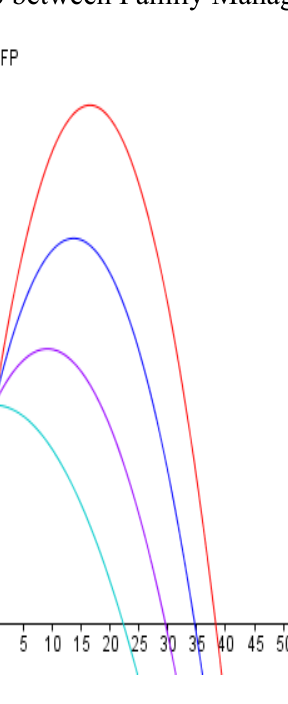
Figure 3. Significant Interactions between Family Management and Noncontrolling Provision. The positive moderation effects of Noncontrolling Provision makes the inverted U-shaped relationship between Family Management and Firm Performance steeper.